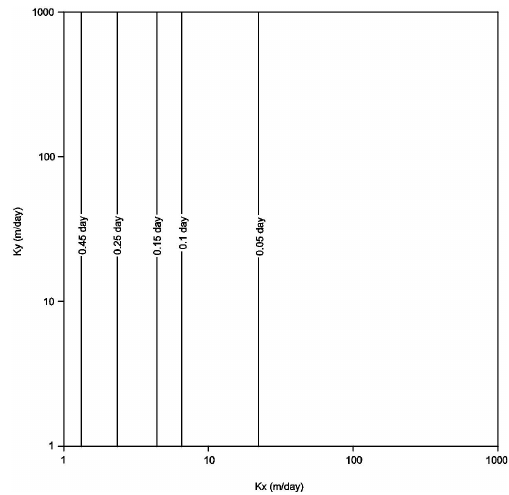
Fig. 6. Contours for the time for reaching quasi-steady state SDR for x 0 D = 4, L D = 1, and various hydraulic conductivities K x and K y .